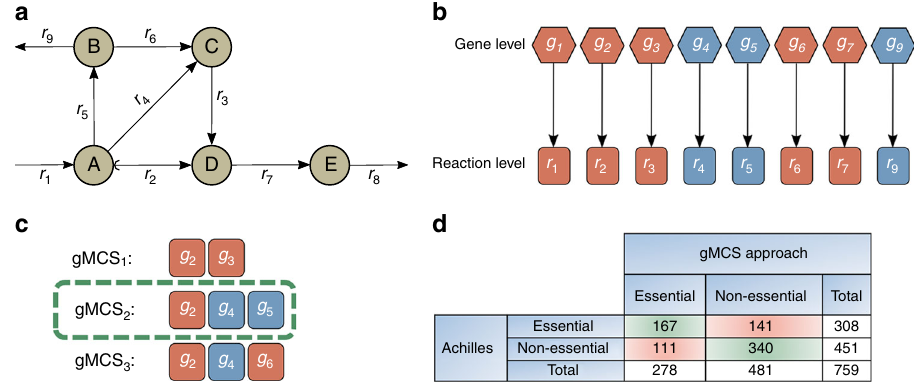
Fig. 1 Identi fi cation of cancer-speci fi c essential genes using our gMCS approach. a Example metabolic network. The target reaction is r 8 . b Trivial gene – protein-reaction (GPR) rules scenario for a . Blue coloring is associated with lowly expressed genes, L = {4, 5, 9}, and red coloring is associated with moderately/highly expressed genes or reactions lacking gene annotation, L = {1, 2, 3, 6, 7}. c Resulting gMCSs involving g 2 given the GPR rules in b . gMCS 2 explains the essentiality of g 2 . d Contingency table with the essentiality predictions of the gMCS approach in the Project Achilles 19